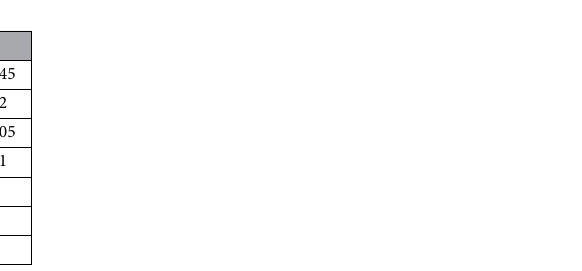
Table 6. Analysis of the first direction residual stress shrinkage